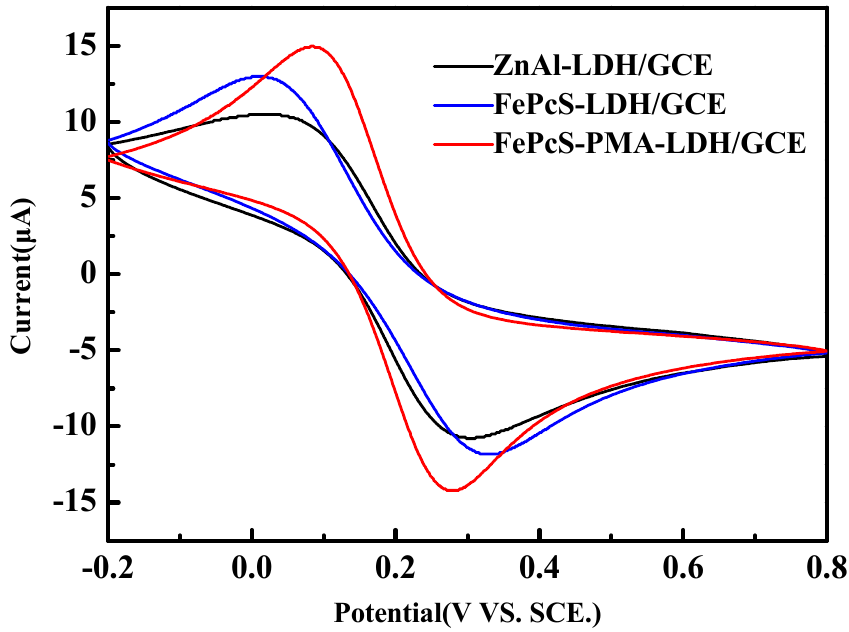
Figure 12. Cyclic voltammetry of ZnAl-LDH/GCE, FePcS-LDH/GCE, and FePcS–PMA–LDH/GCE in 0.1 M KCl solution containing K 3 [Fe(CN) 6 ]/K 4 [Fe(CN) 6 ] (both 5 mM) with a scan rate of l0 mV/s.